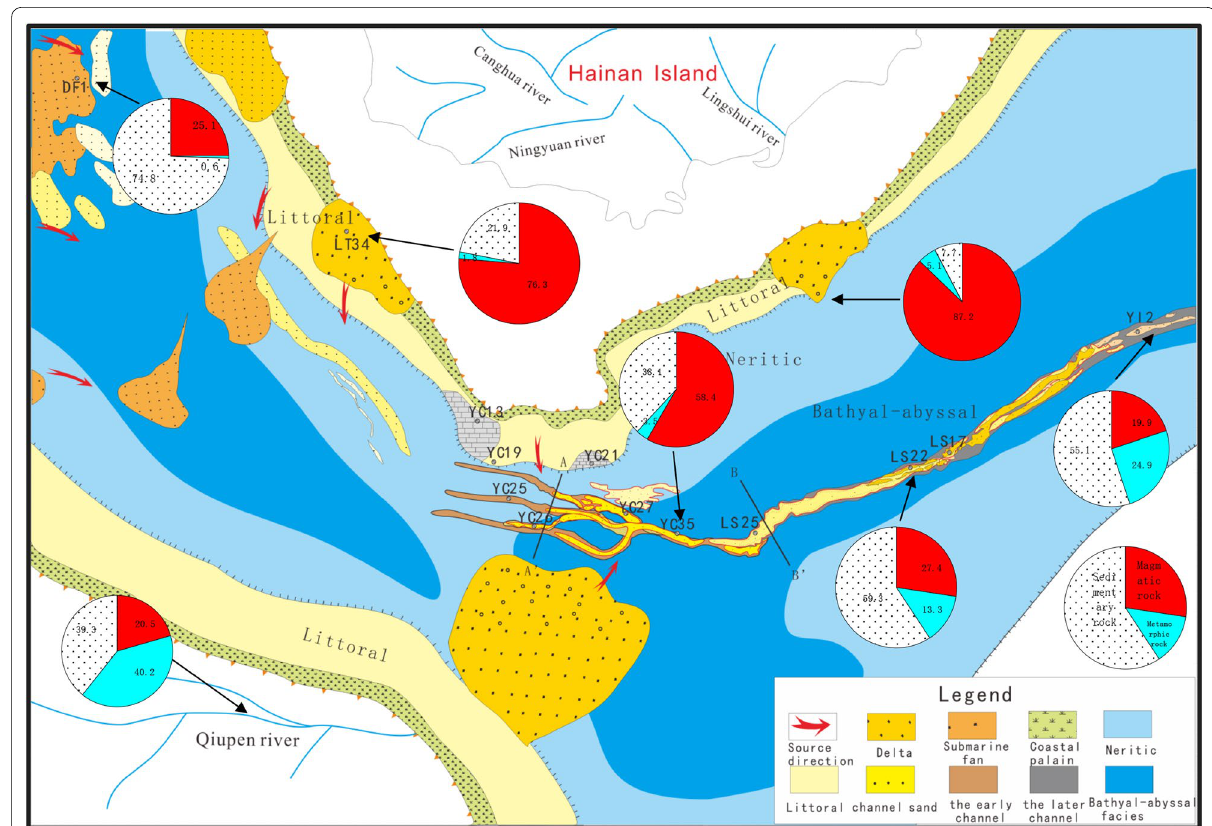
Fig. 2 Sedimentary facies and rock compositions of the Huangliu Formation in northern South China